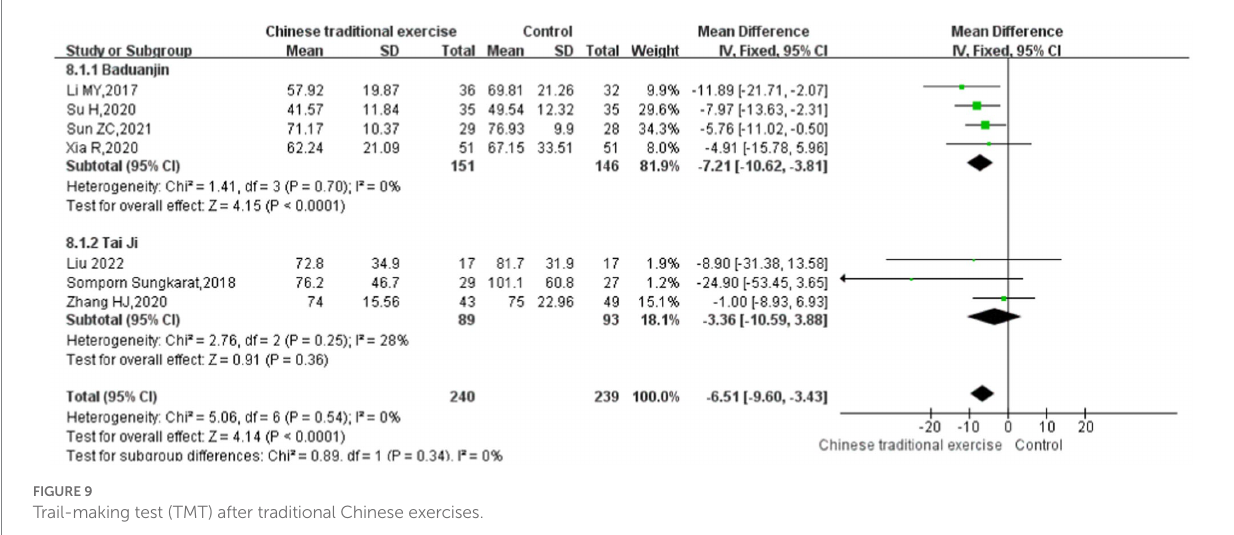
FIGURE 9 Trail-making test (TMT) after traditional Chinese exercises.